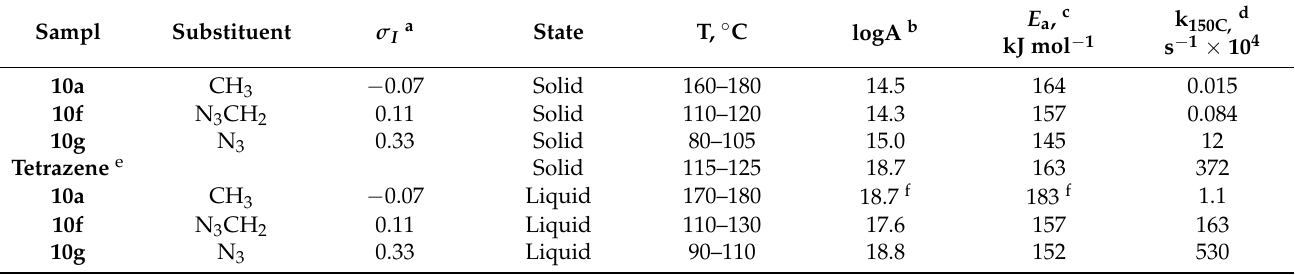
Table 2. Parameters of the Arrhenius equation for perchlorates and benchmark tetrazene. Sampl